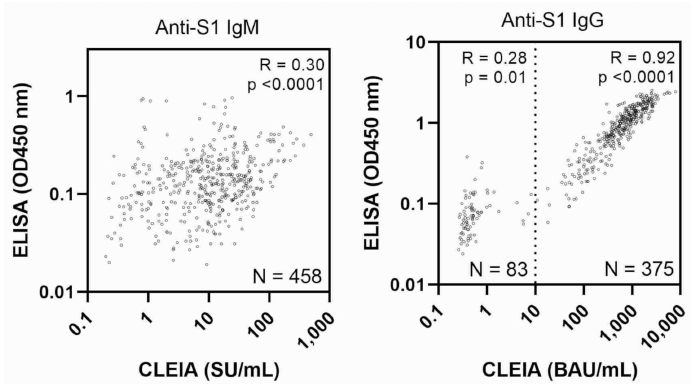
Figure 3. Comparison of SARS-CoV-2 specific antibody levels measured by CLEIA and ELISA. Scatter plots show the levels of anti-spike protein S1 IgG and IgM in serum samples from all participants measured by CLEIA and ELISA. N indicates total number of blood samples taken from participants (Supplementary Table S2). The dashed line represents 10 BAU/mL and the plot is divided into high and low concentration ranges. Correlation coefficients (R), p -values, and N are shown for each